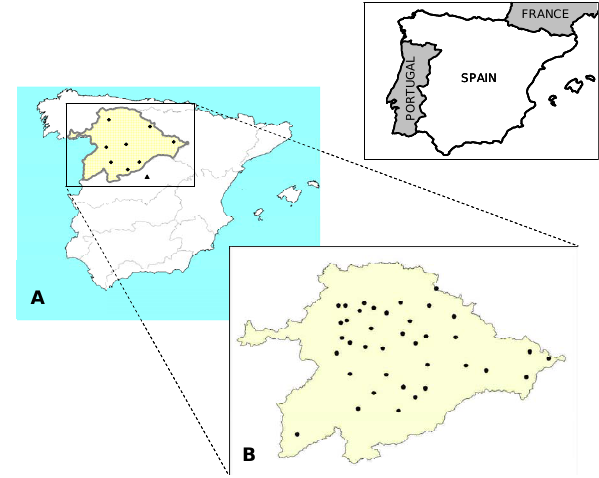
Fig 1. Location of study area. A, locations of meteorological stations used to calculate Fig. 1. Location of study area. (A) locations of meteorologi- cal stations used to calculate scenarios, points: stations with data scenarios, points: stations with data for Maximum Temperature (T ), Minimum for Maximum Temperature ( T max ) , Minimum temperature ( T min ) temperature (T ) Maximum Relative Humidity (HR ), Minimum Relative Humidity Maximum Relative Humidity (RH max ) , Minimum Relative Humid- (HR ), Wind Speed (U). Triangle: station with Global Radiation data. B, locations of ity (RH min ) , Wind Speed ( U ). Triangle: station with Global Ra- diation data. (B) locations of agrometeorological stations used to agrometeorological stations used to simulate scenarios. simulate